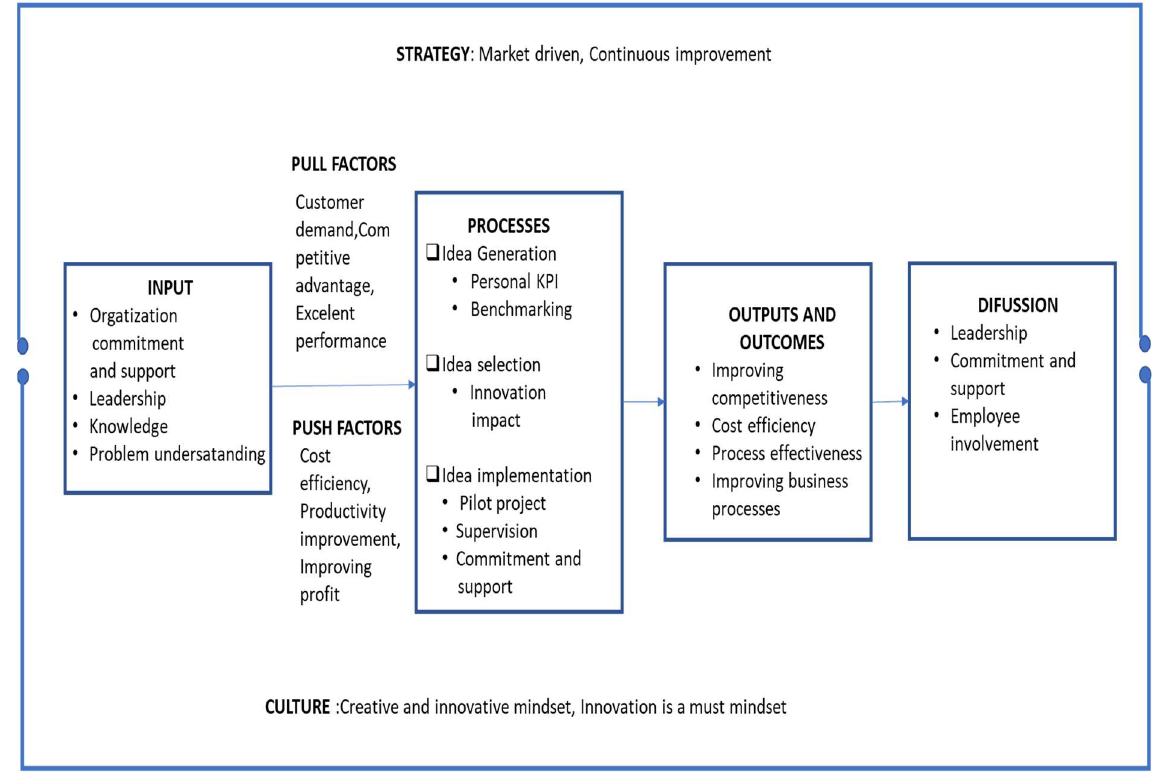
Figure 2. Success factors of process innovation in Indonesian SOEs. (Source: Authors’ elaboration).